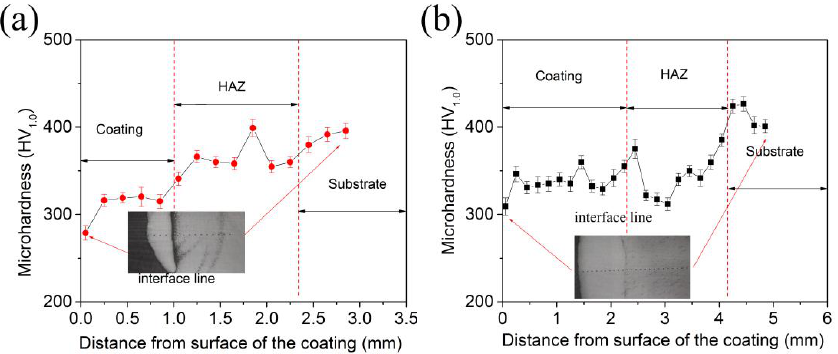
Figure 7. Microhardness of specimens as a function of distance from surface of monolayer ( a ) and trilayer coatings ( b ).